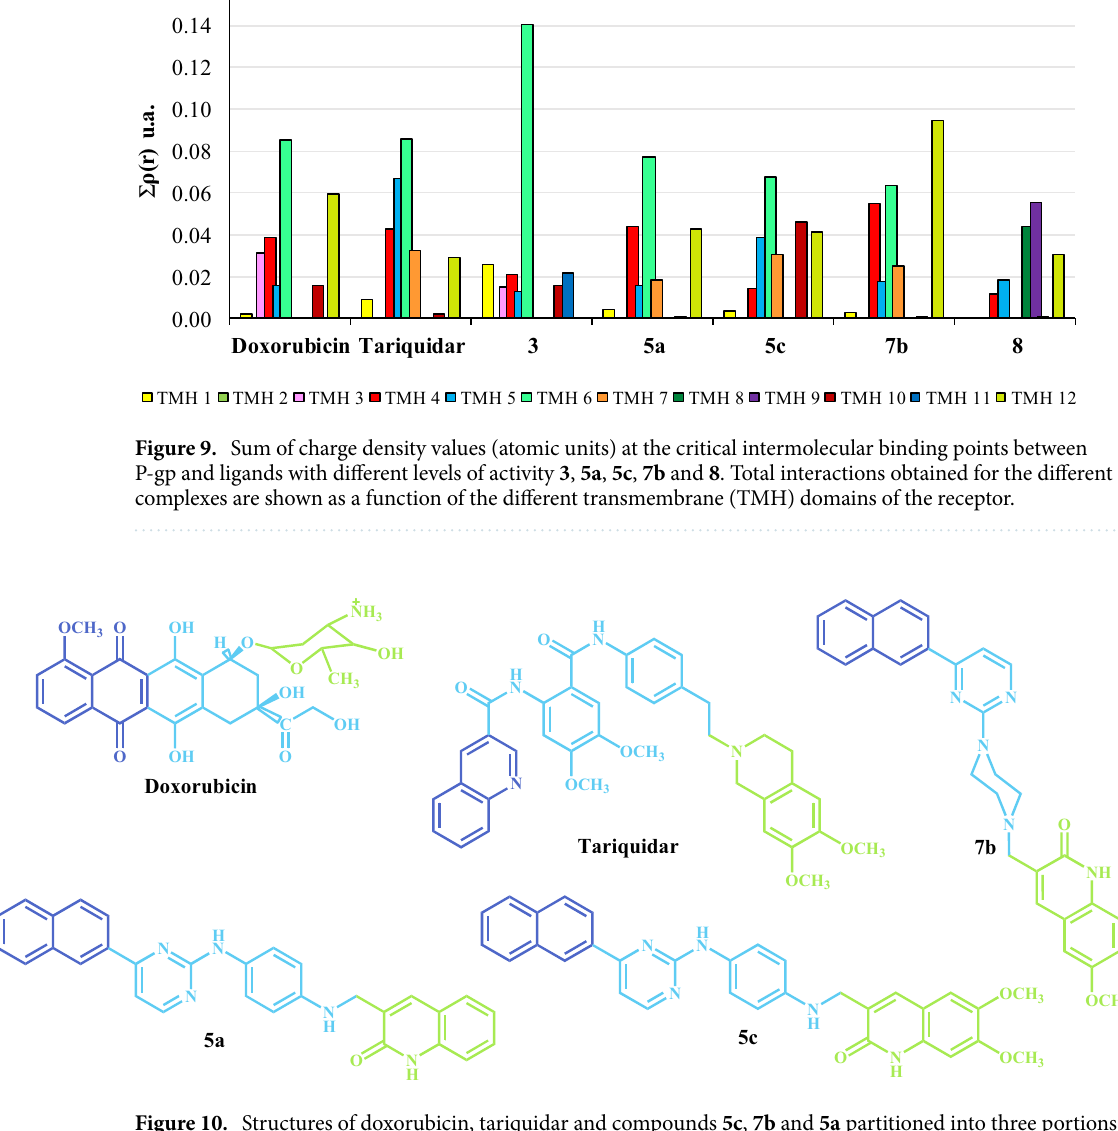
Figure 10. Structures of doxorubicin, tariquidar and compounds 5c , 7b and 5a partitioned into three portions: moiety 1 (blue), linker (green) and moiety 2 (light